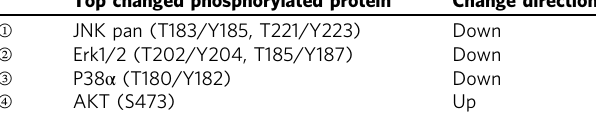
Table 3 Top changed phosphorylated (P)-proteins in Lkb1 d/ d Pten d/d lungs (pretumor stage) compared to wild-type (WT) lungs at 1 month of